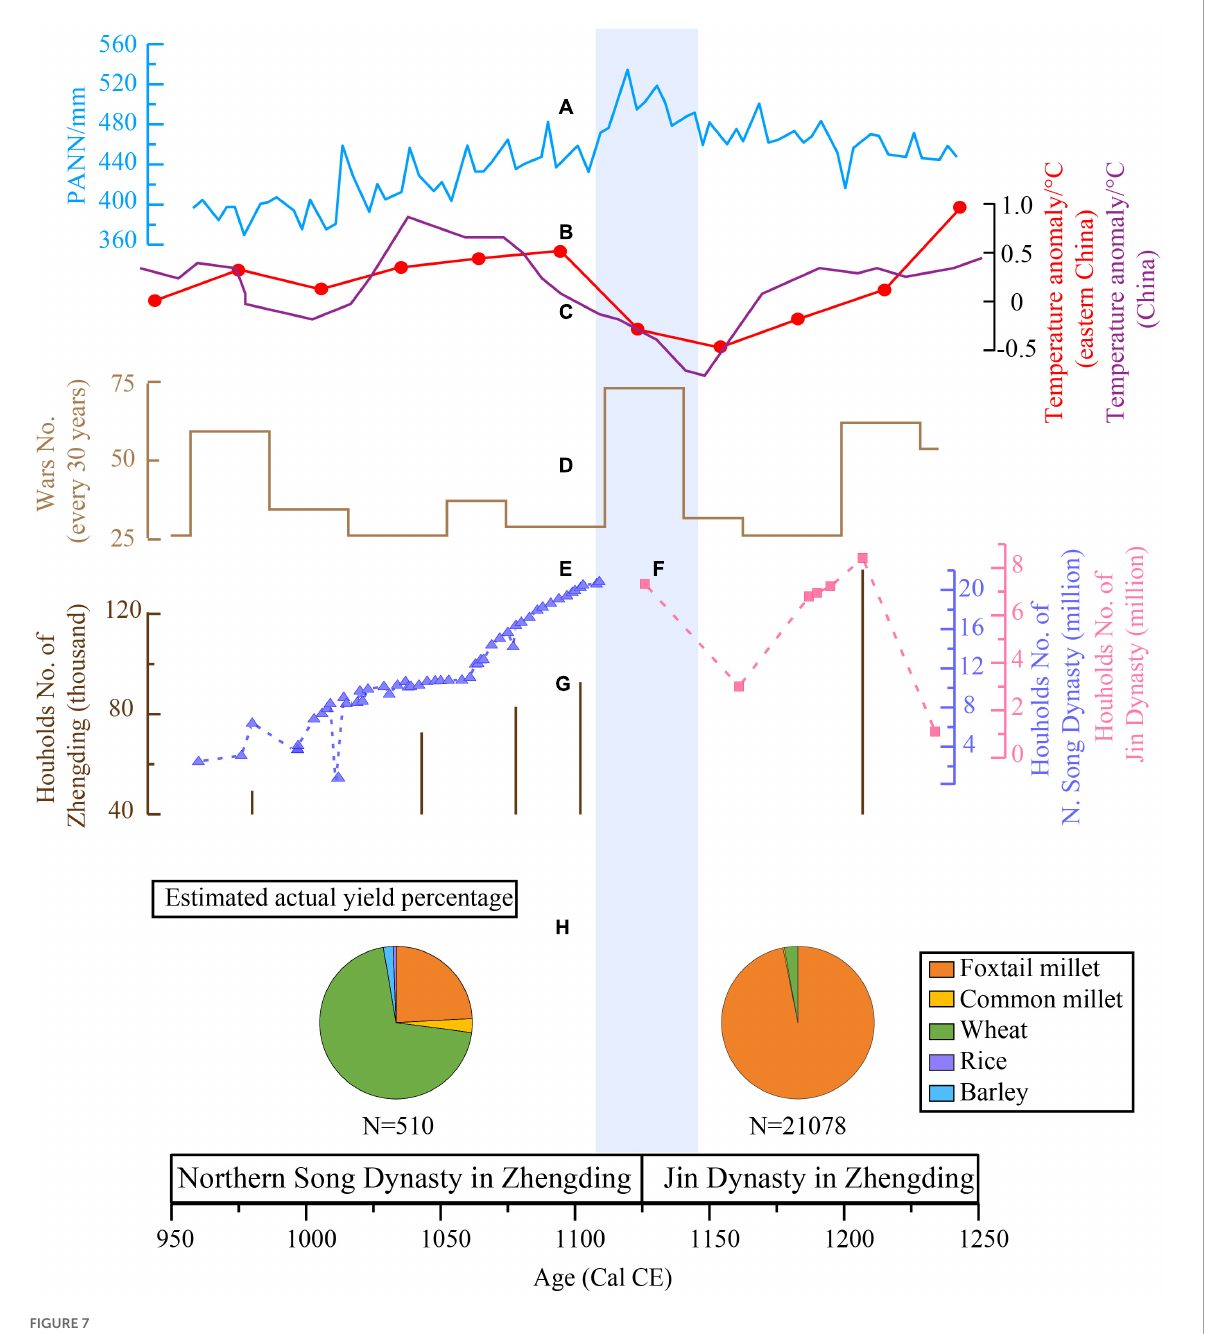
FIGURE7 Comparison of estimated actual yield percentage (H) of major crops with historical and climatic records: (A) Reconstructed PANN from Gonghai lake (Chen et al., 2015b); (B) winter half-year temperature anomaly change in eastern China (Ge et al., 2003); (C) China-wide temperature composites established by combining multiple paleoclimate proxy records (Yang et al., 2002); (D) war number (Ge et al., 2014); Households number of (E) Northern Song and (F) Jin dynasties and (G) Zhengding prefecture (Wu, 2000). The blue strip represents the cold event in the 12th